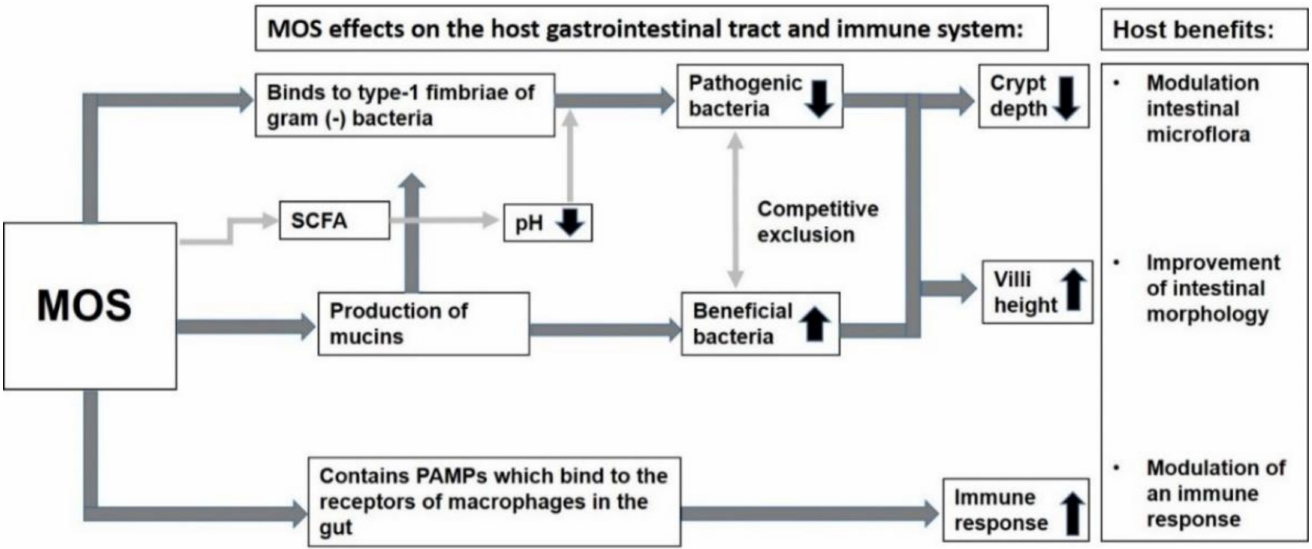
Figure 2. Mechanism of action of MOS. The diagram shows how MOS modulate the intestinal microflora, improve the intestinal morphology and elicit an immune response. The black arrows pointing upwards mean an “increase” in response, while the arrows pointing downwards mean a “decrease” in